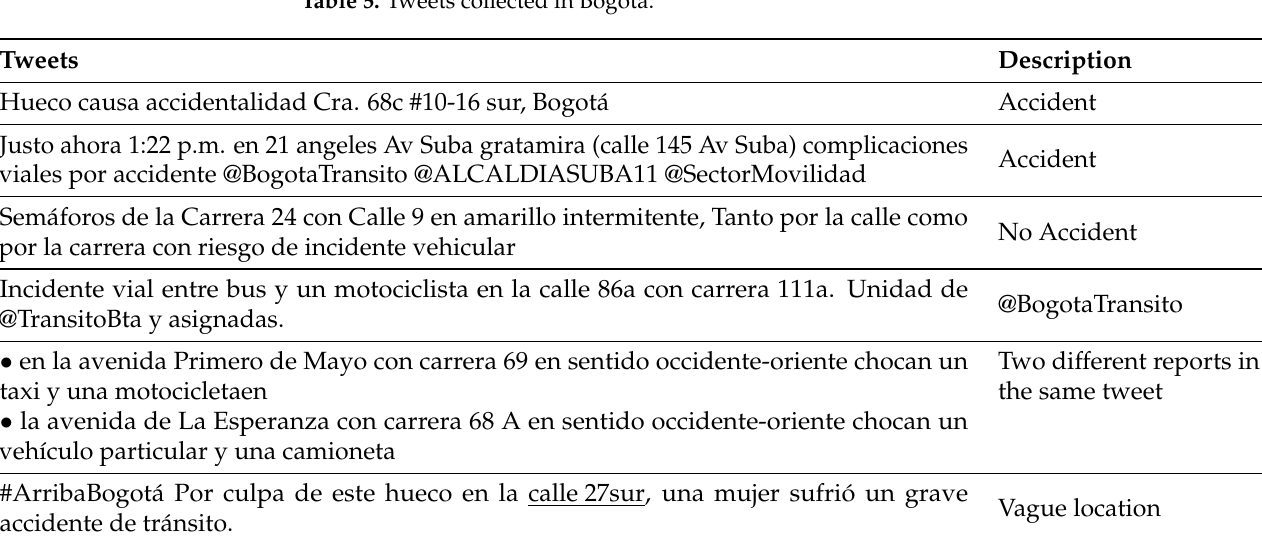
Table 5. Tweets collected in